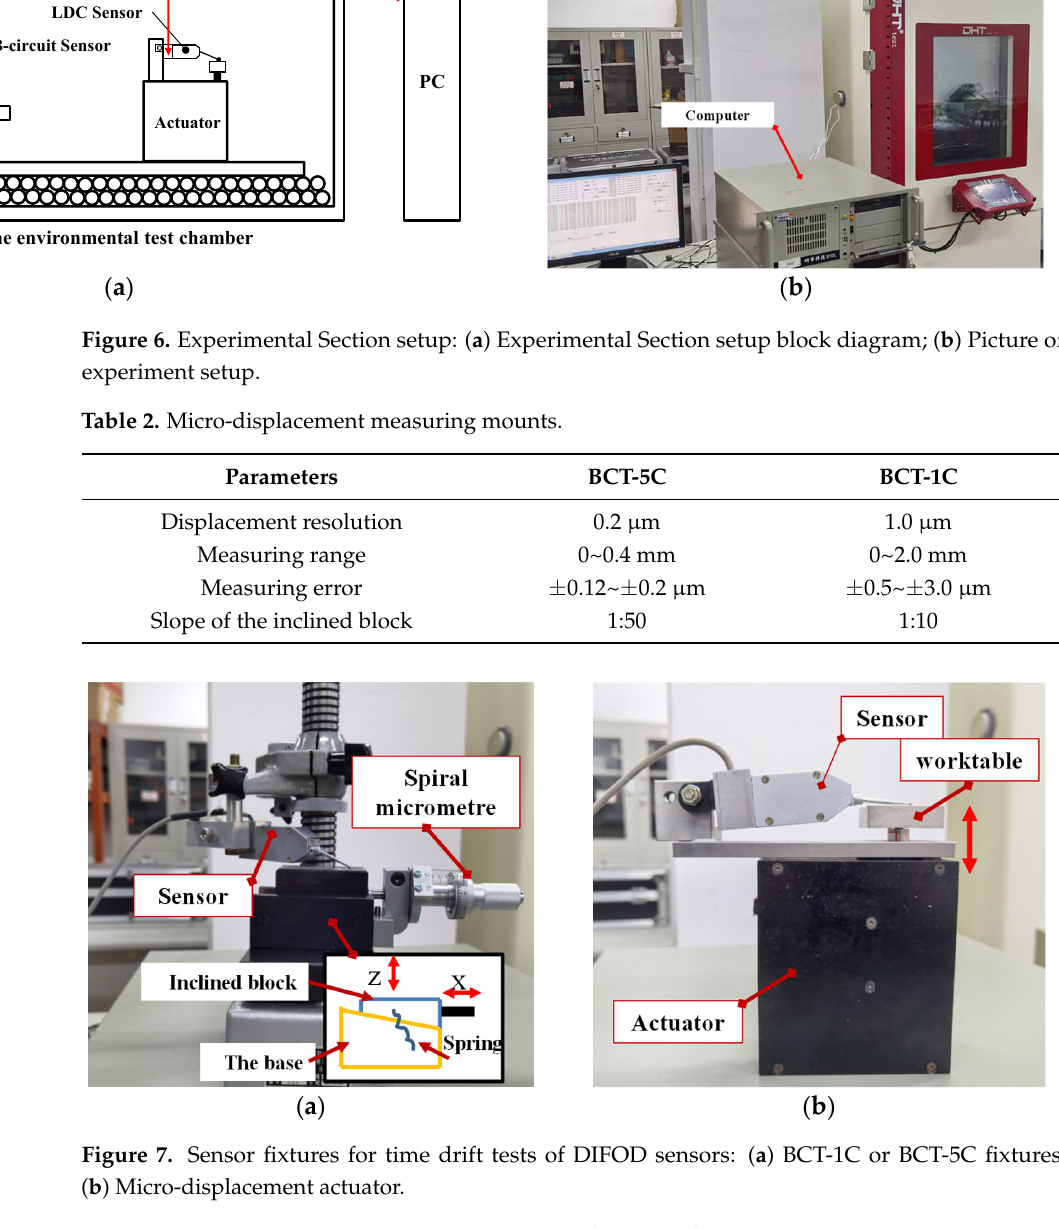
Figure 7. Sensor fixtures for time drift tests of DIFOD sensors: ( a ) BCT ‐ 1C or BCT ‐ 5C fixtures; ( b ) Micro ‐ displacement actuator.